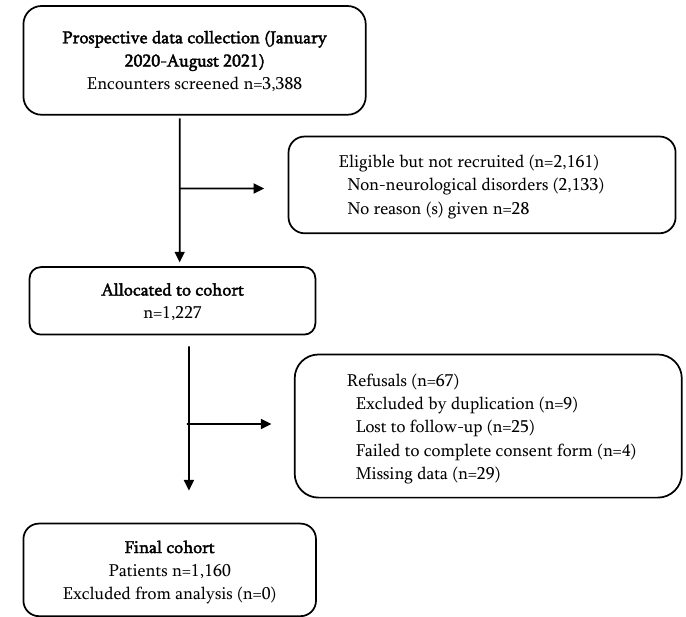
Figure 1. Participant inclusion flow